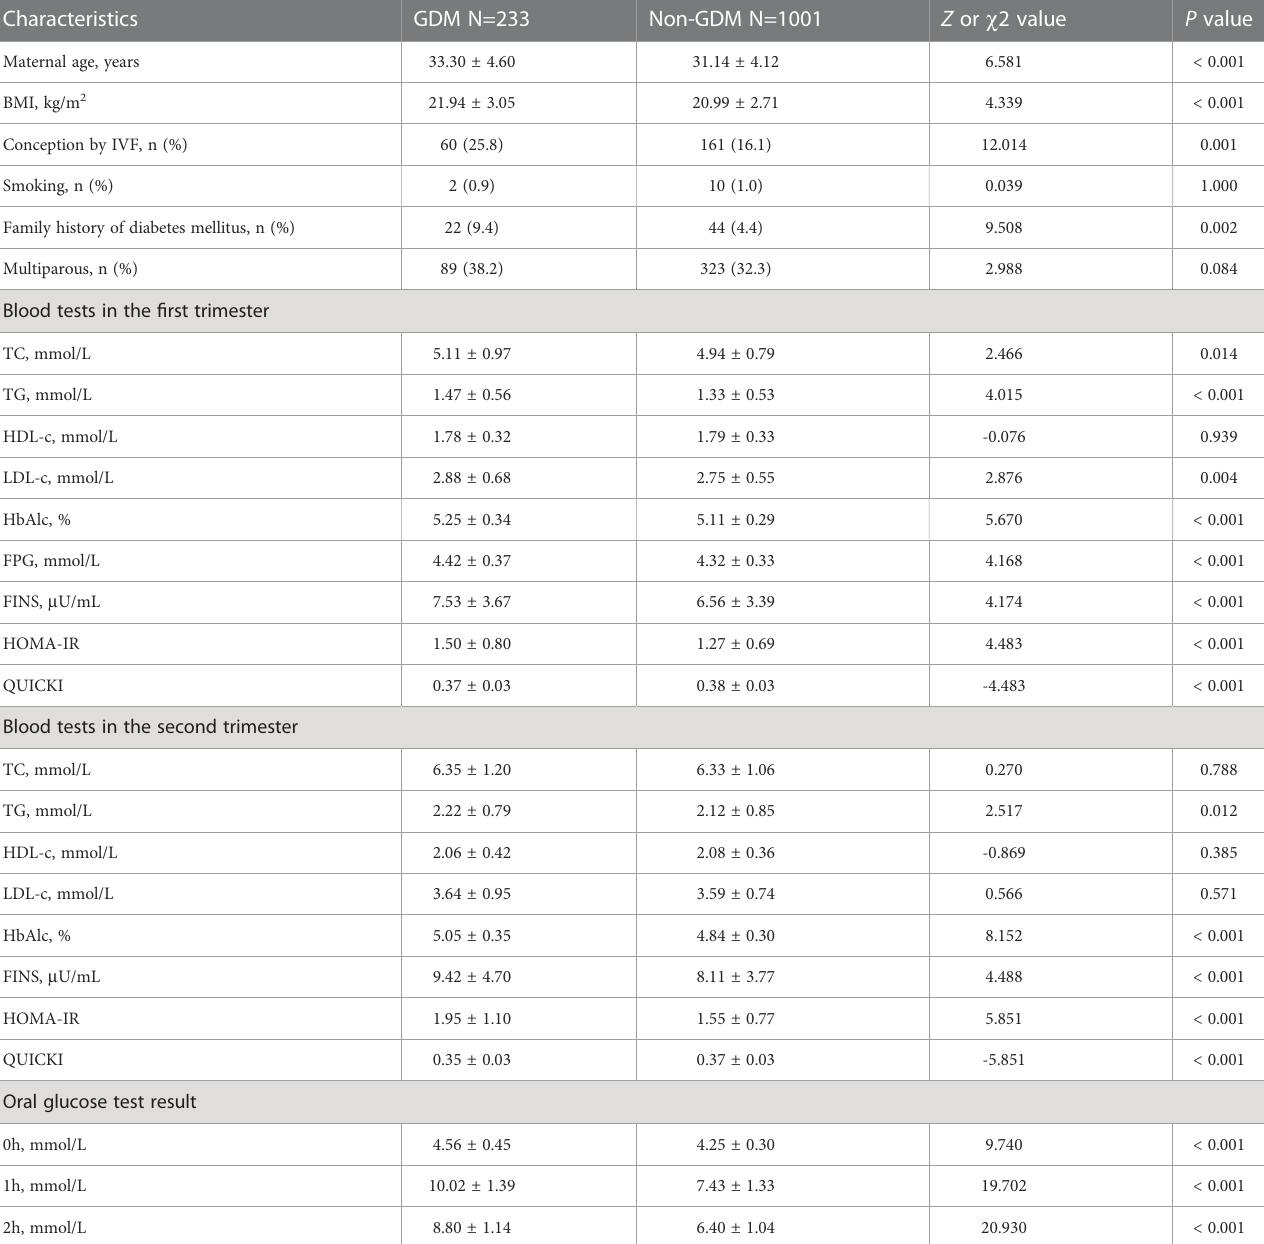
BMI, body mass index; IVF, in vitro fertilization; TC, total cholesterol; TG, triglycerides; HDL-c, high-density lipoprotein cholesterol; LDL-c, low-density lipoprotein cholesterol; HbA1c, hemoglobin A1c; FPG, fasting plasma glucose; FINS, fasting insulin; HOMA-IR, homeostasis model assessment of insulin resistance; QUICKI, quantitative insulin sensitivity check